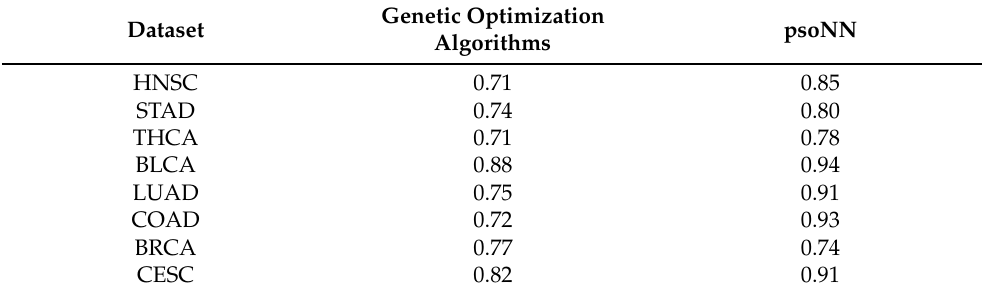
Table 5. Comparison of the prediction accuracy of genetic optimization algorithms and psoNN.